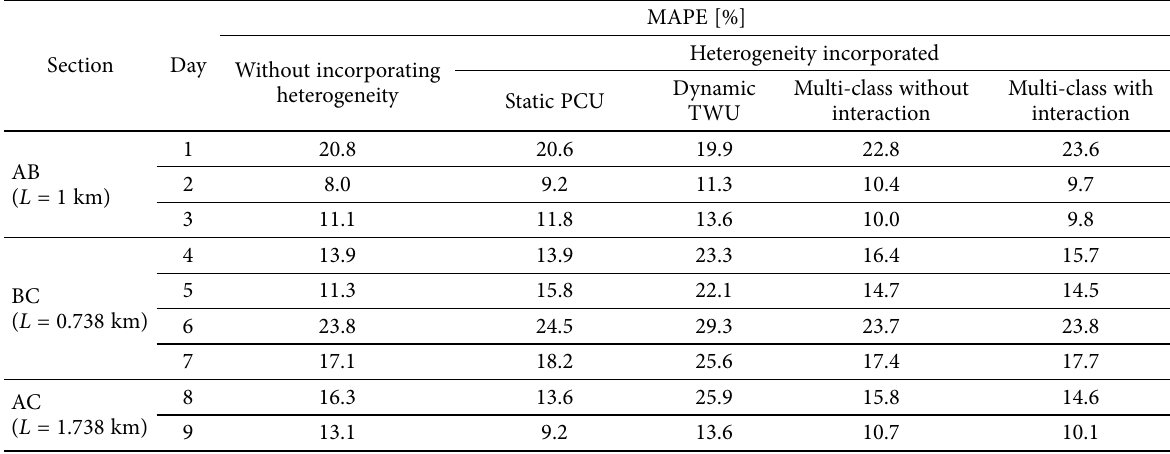
Table 4. MAPE for density